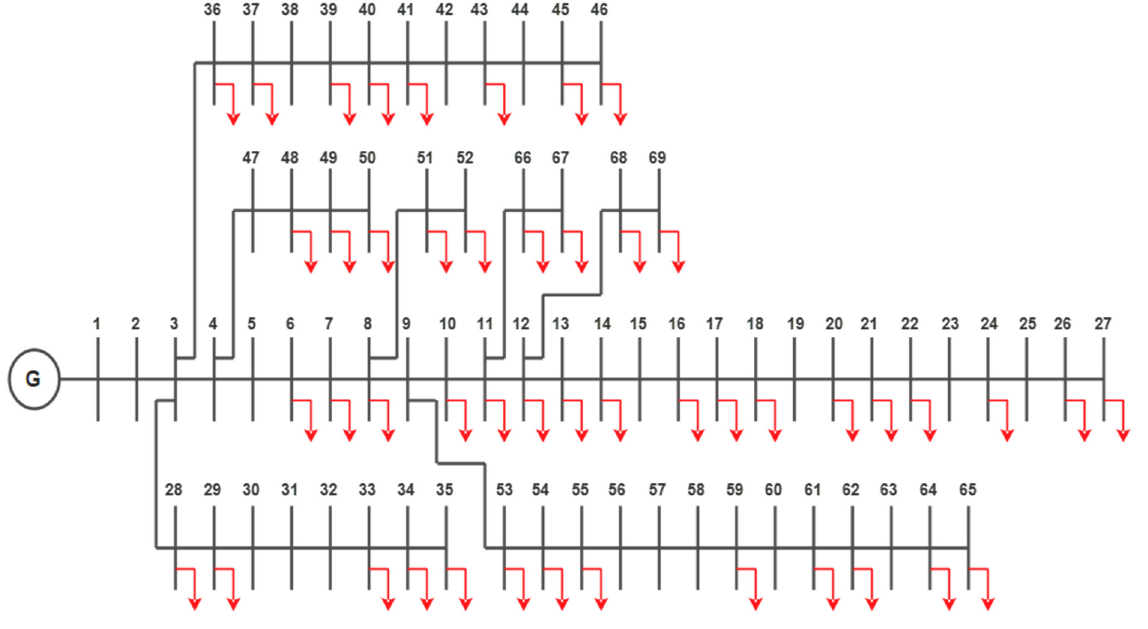
Figure 7. Single-line diagram of a 69-bus RDS.